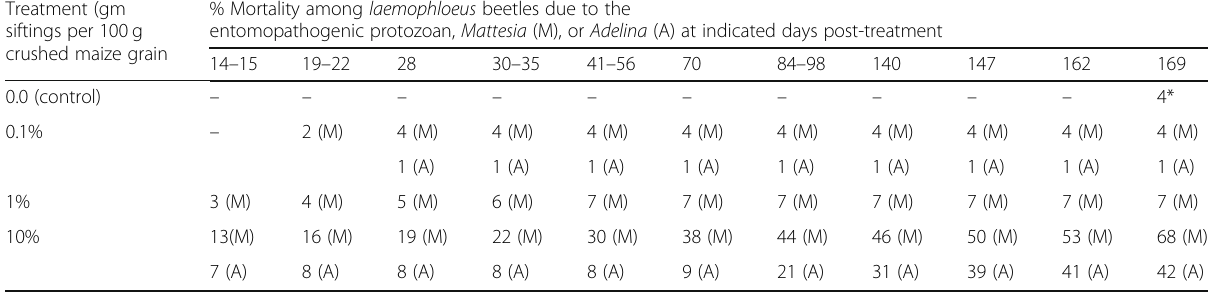
Table 8 Siftings from protozoan-infected cultures of Laemophloeus turcicus beetles as a potent source of natural mortalities in their populations Treatment (gm siftings per 100 g crushed maize grain